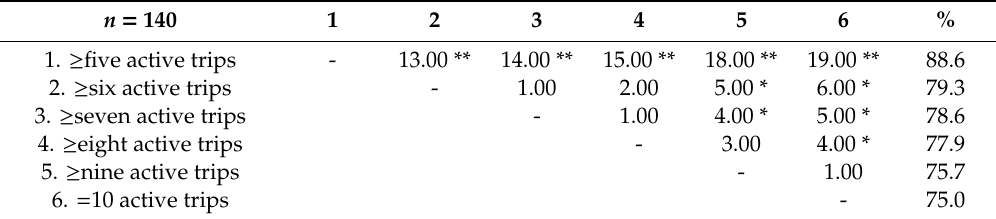
Table 1. Cochran’s Q test values for the percentage of active commuters depending on the number of weekly active trips to and from school.